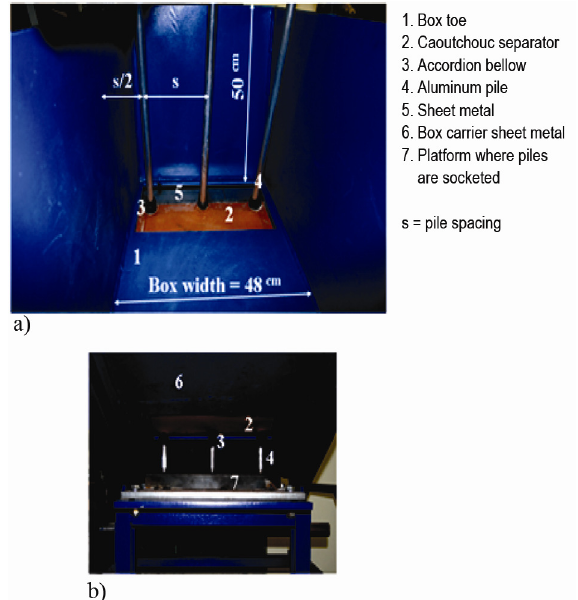
Fig. 3. Photograph of model box with piles: a) Inside view; b) Bottom